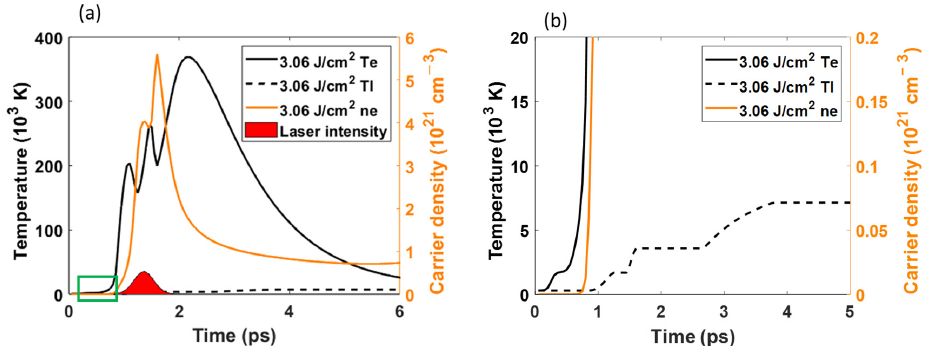
Figure 7. ( a ) The temporal electron temperature, lattice temperature, and carrier density calculated for 3.06 J/cm 2 , ( b ) the magnification images of the green square of ( a ).